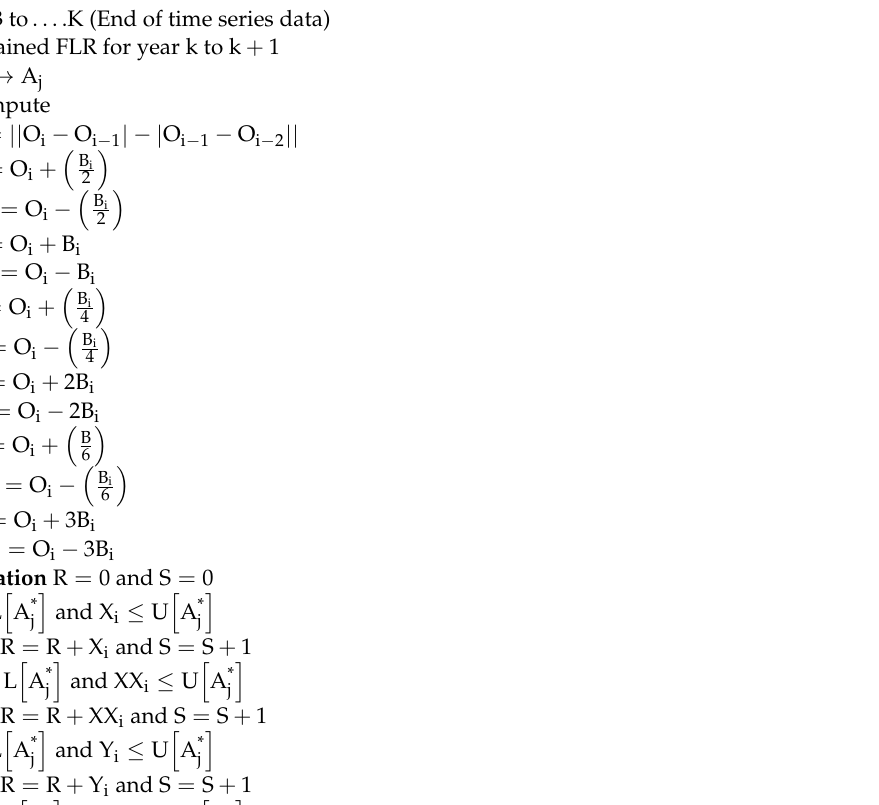
Algorithm 4. Rules of